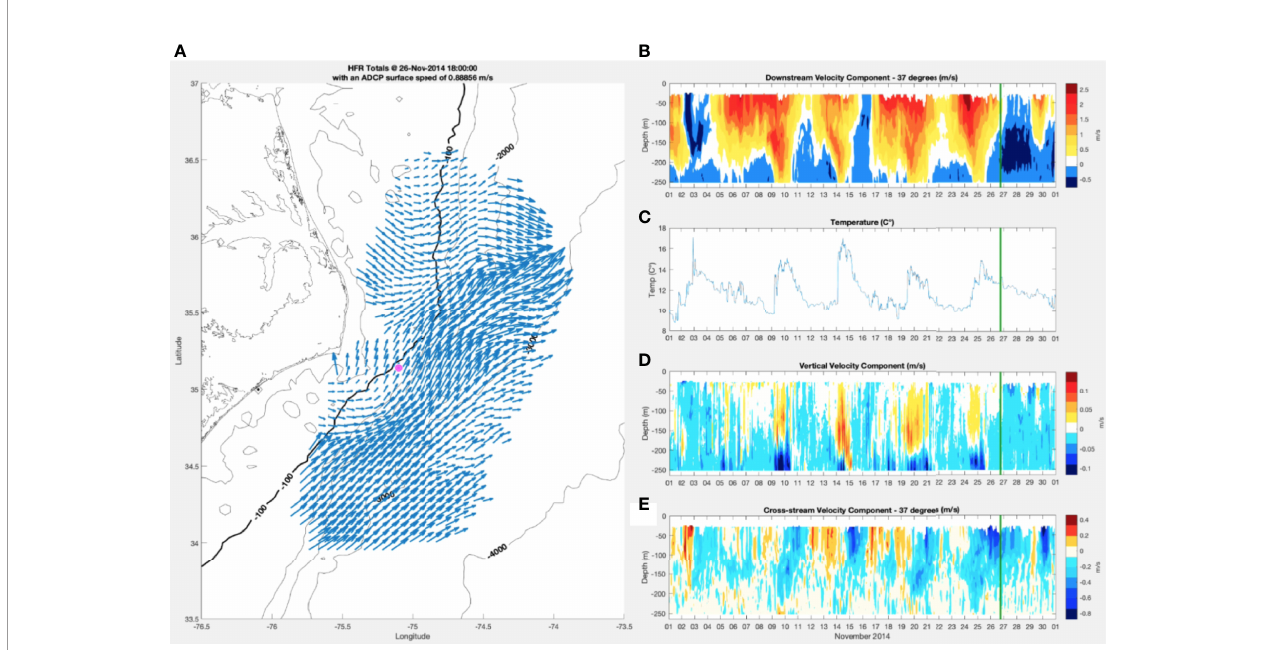
FIGURE 8 | Left: HFR surface currents (A) on November 26 at 18:00 GMT, with ADCP location at red asterisk. Right: ADCP downstream velocity contour (B) , bottom temperature (C) , vertical velocity contour (D) , and cross-stream velocity contour (E) , with green vertical line at November 26 at 18:00